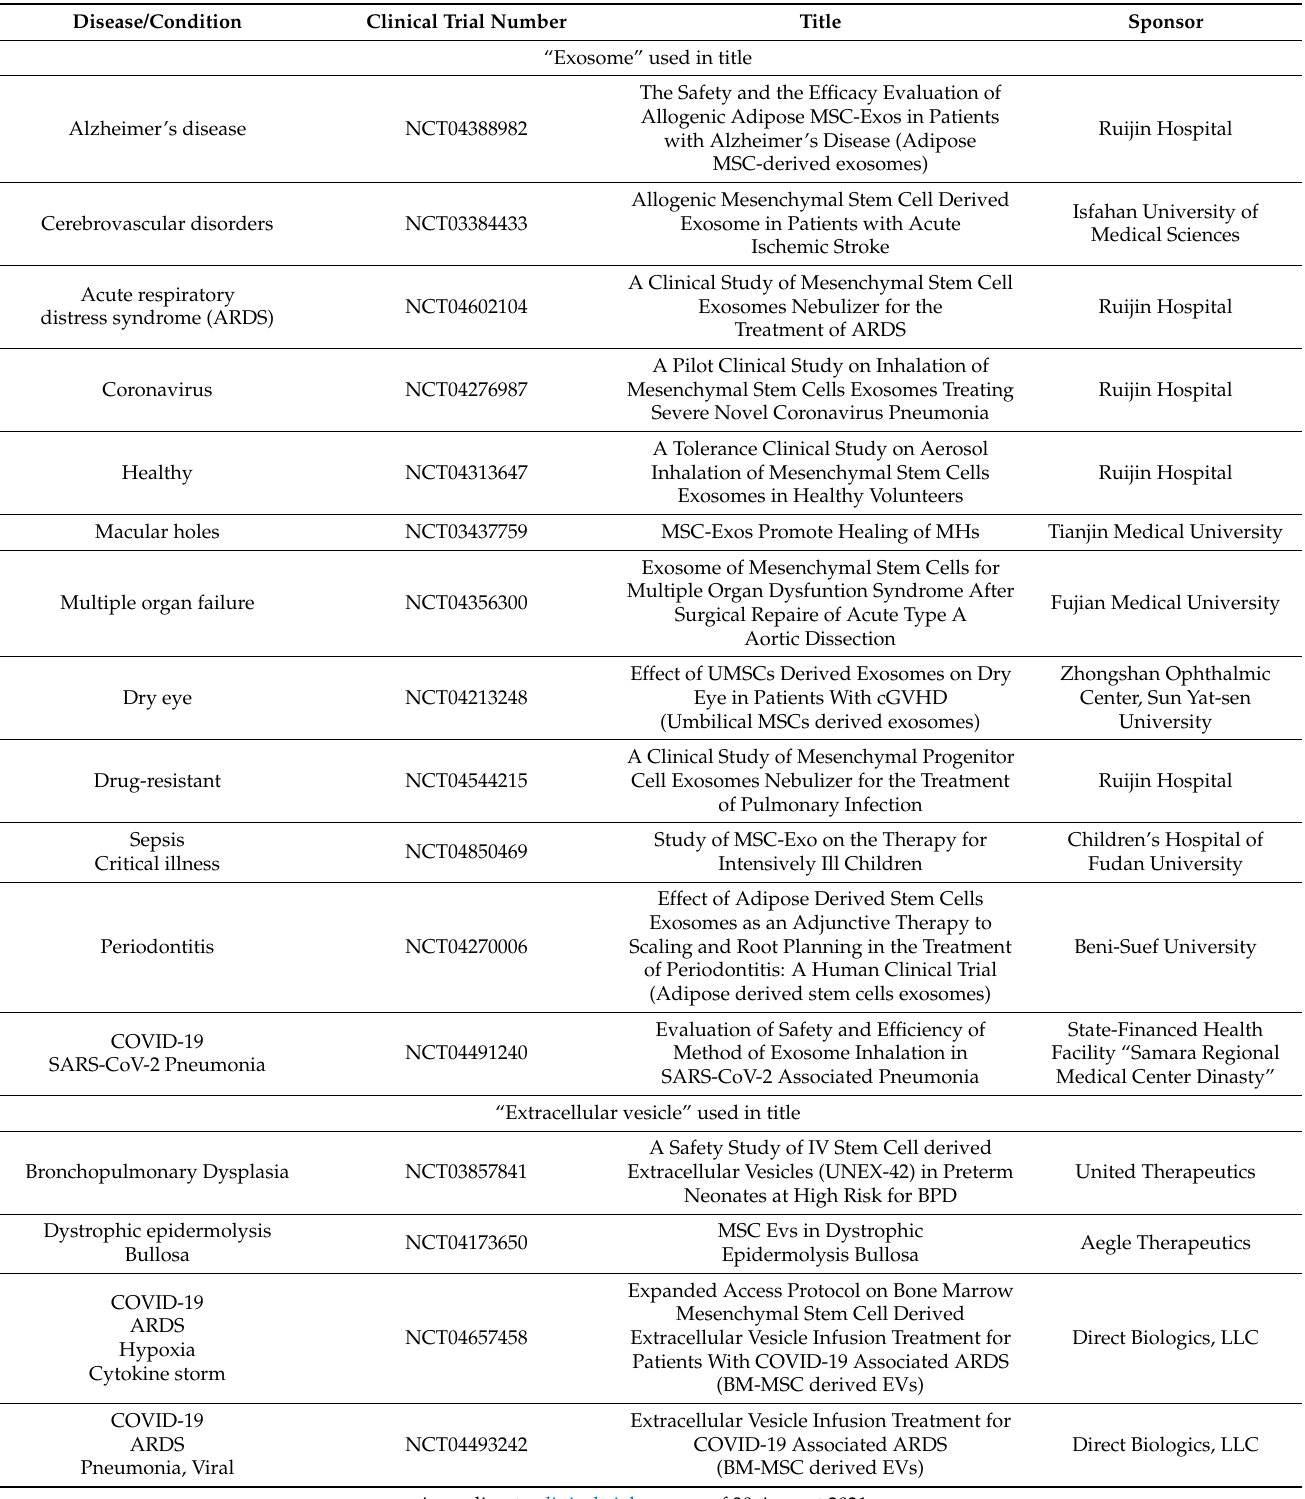
Table 2. Clinical trials using MSC-derived EVs in